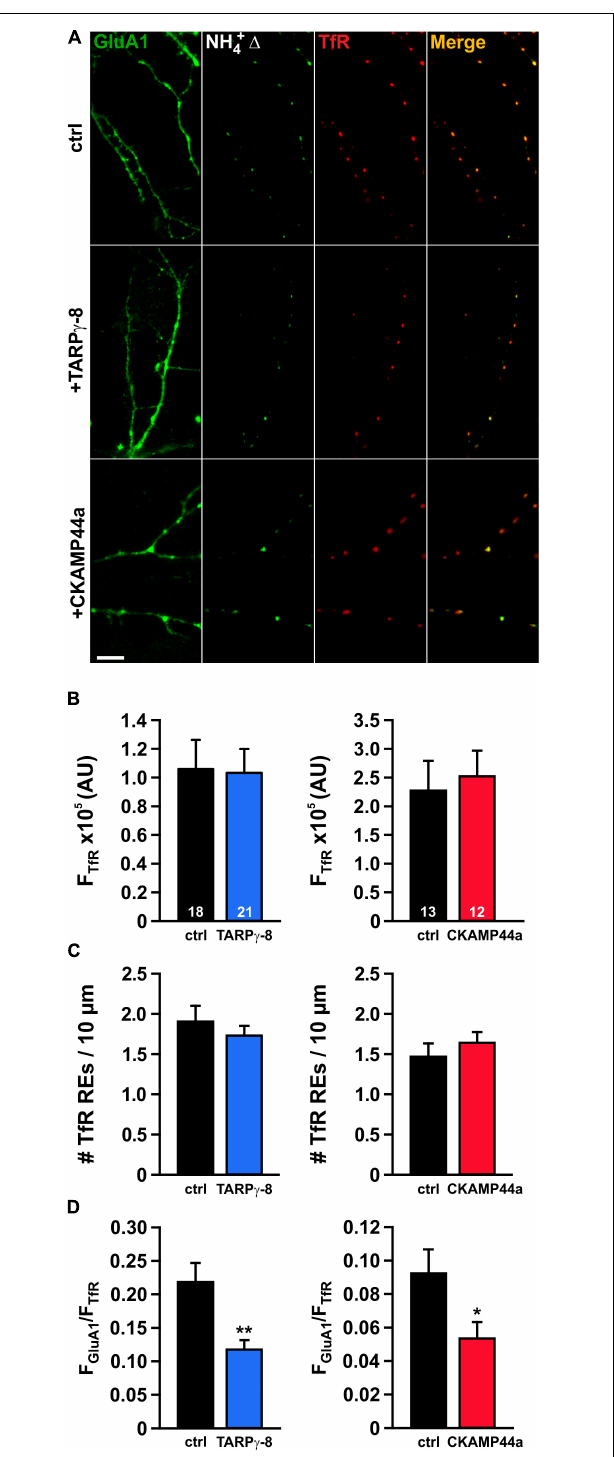
FIGURE 4 | The AMPAR pool in recycling endosomes is decreased in neurons overexpressing auxiliary subunits. (A) Exemplary images of dendritic segments of neurons transfected with SEP-GluA1 and TfR-tagRFPt (top row), or neurons additionally expressing either TARP γ -8 (middle row) or CKAMP44a (bottom row) (scale bar = 10 µ m). To highlight AMPARs in intracellular